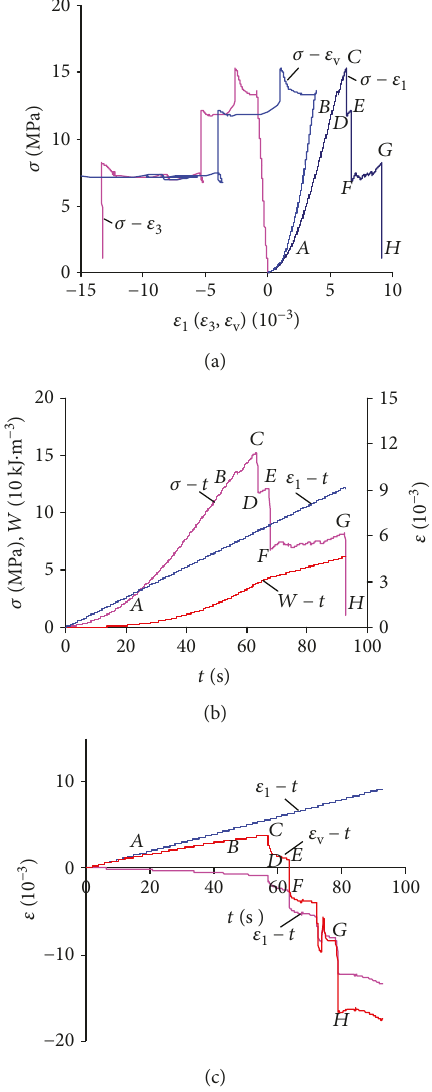
Figure 4: Stress (strain, energy) versus time curves for MS2 under uniaxial